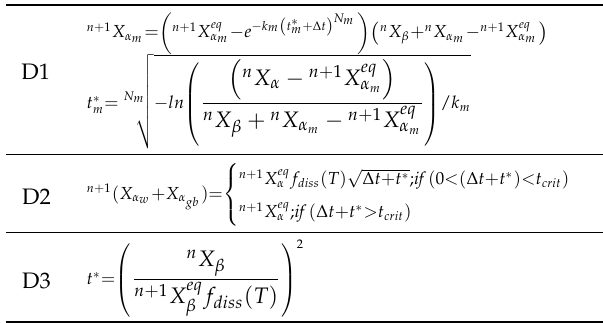
Table 2. Models for α -phase dissolution.